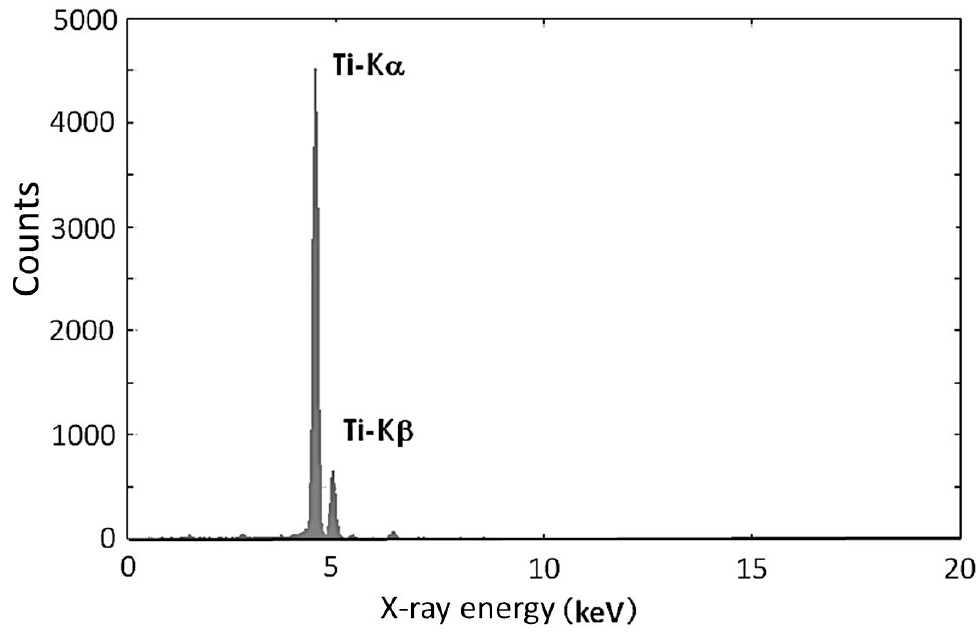
Figure 1. X-ray energy spectrum of a Ti target bombarded with 3 MeV α particles.